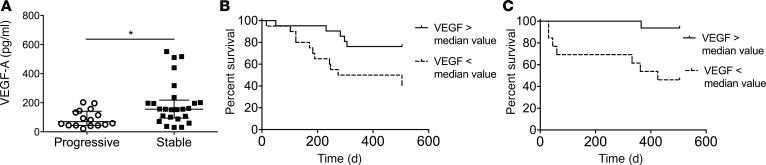
Reduced plasma VEGF is predictive of all-cause mortality in 2 independent IPF cohorts.(A) Relative to subjects with stable disease (n = 25), idiopathic pulmonary fibrosis (IPF) subjects with progressive disease (n = 16) show reduced concentration of VEGF in plasma as compared via Mann Whitney U test. Data are shown as median with interquartile range. (B and C) Kaplan-Meier plot for the composite endpoint of all-cause mortality, absolute drop of > 10% in forced vital capacity (FVC), or acute exacerbation reveals a significant survival benefit for subjects with a VEGF concentration exceeding the median value (top line) relative to those with a plasma VEGF concentration below the median value (bottom line). These findings were derived from a longitudinal cohort of IPF subjects followed at the Yale Interstitial Lung Disease (ILD) Center of Excellence (B) and validated in archived samples from the Yale Lung Repository (C). *P ≤ 0.05.